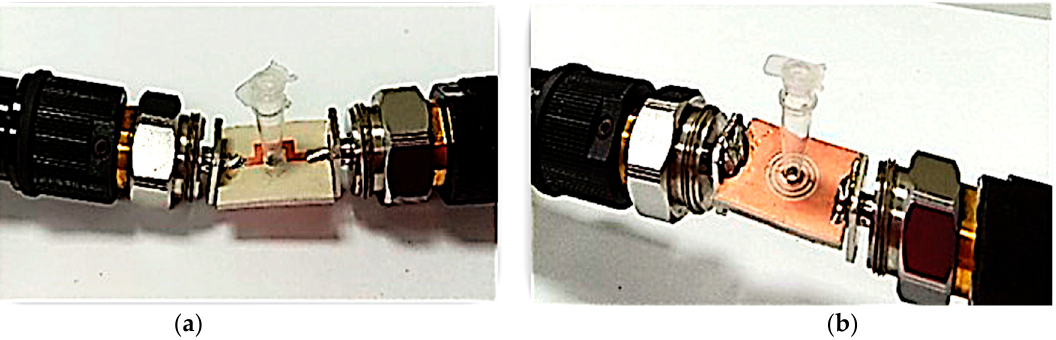
Sensors 2023 , 23 , x FOR PEER REVIEW